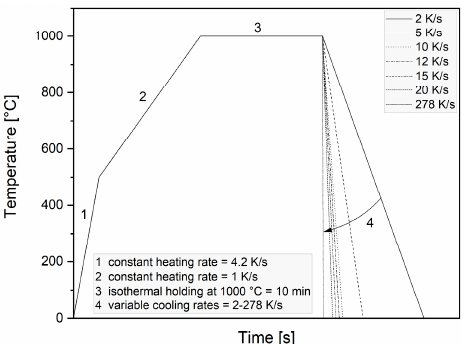
Figure 2. Time–temperature-profile of sample production experiments: after heating (1,2) samples are austenitized at 1000 °C for 10 min (3), and then continuously cooled with varying cooling rates (4).